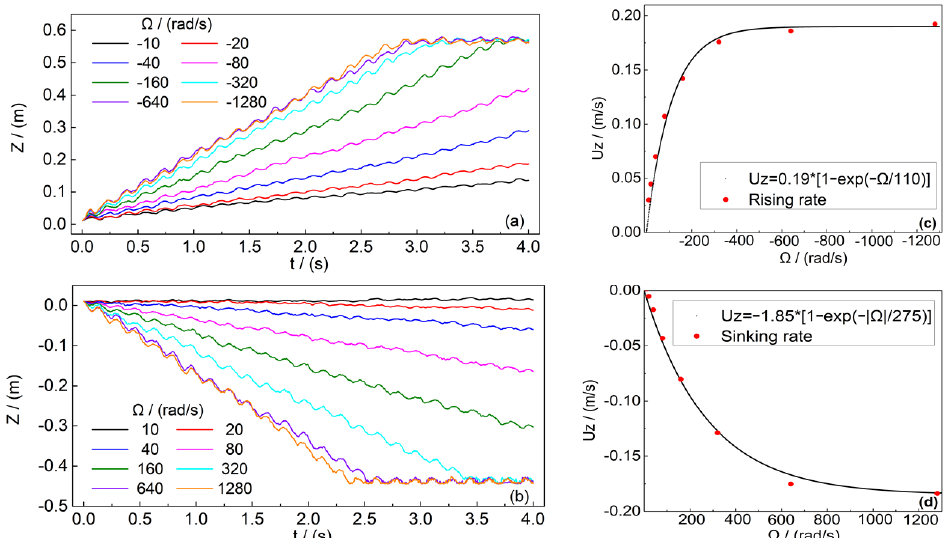
Figure 6. The displacement of the SO in the z direction for fixed translational amplitude A = 0.03 m and oscillatory frequency f = 3 Hz. ( a ) The rising height for Ω < 0; ( b ) the sinking depth for Ω > 0; ( c ) the rising rate for Ω < 0; ( d ) the sinking rate for Ω > 0. The lines in ( c ) and ( d ) represent exponential fits for U z ( Ω )